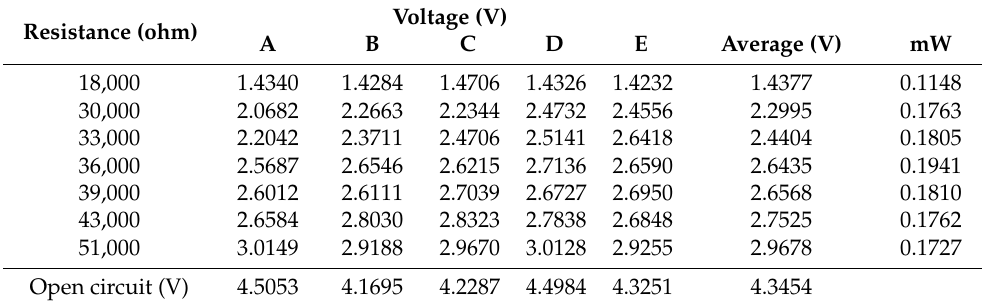
Table 1. Experimental measurement of system